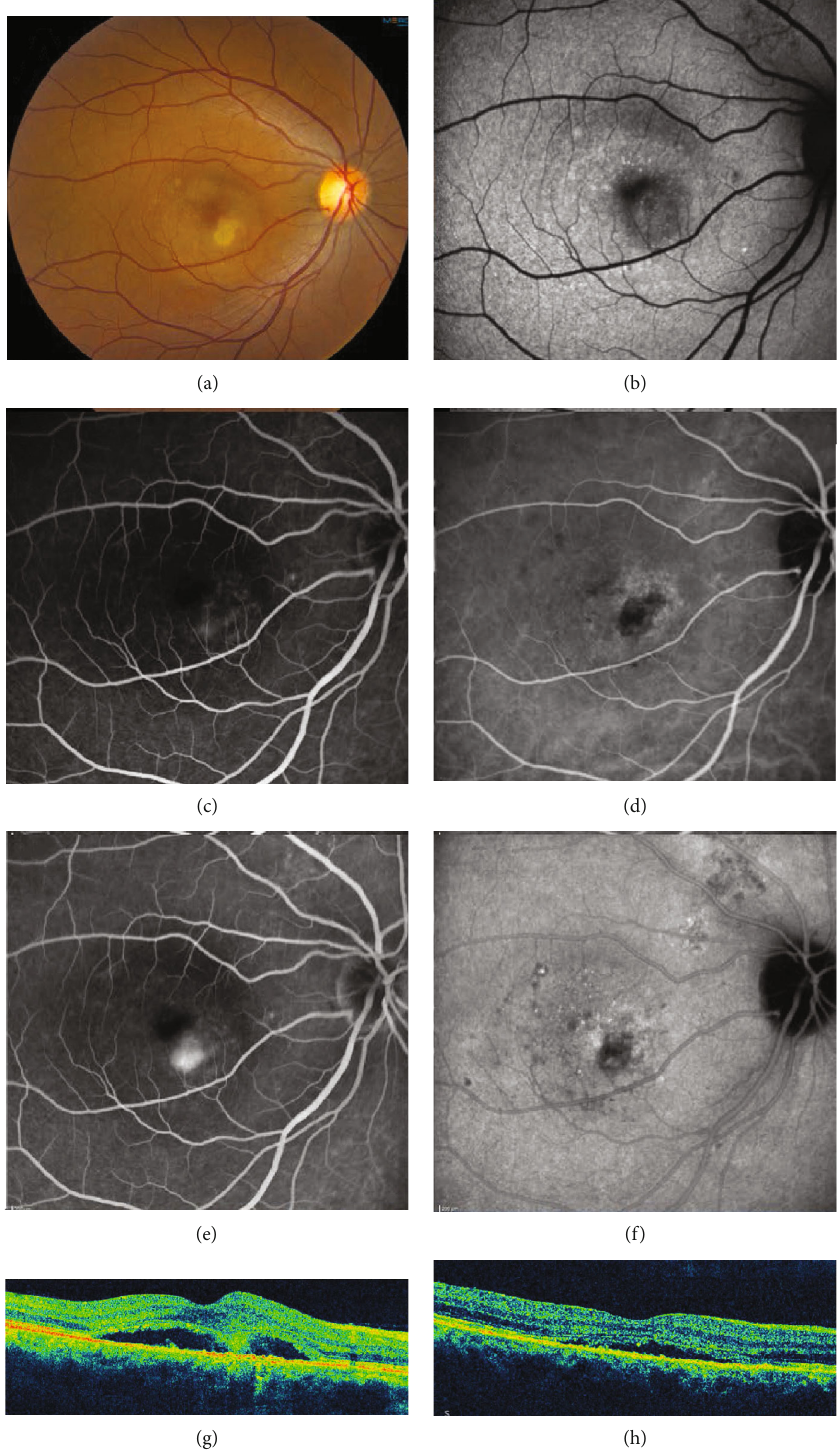
Figure 11: Chronic central serous chorioretinopathy of the right eye treated with reduced fl uence photodynamic therapy (PDT). A 49-year old female presented with blurred vision in the right eye. Visual acuity was 20/50. (a) Fundus photography showed pigmentary changes of the right eye. (b) Fundus auto fl uorescence showed hypoauto fl uorescence at the macula. (c, d) Early-phase fl uorescein angiography (FA) and indocyanine green angiography (ICGA) showed hyper fl uorescence. (e, f) Late-phase FA and ICGA showed leakage in the inferior macula. (g) Optical coherence tomography prior to and (h) after half- fl uence PDT showed improvement of subretinal fl uid. Visual acuity improved to